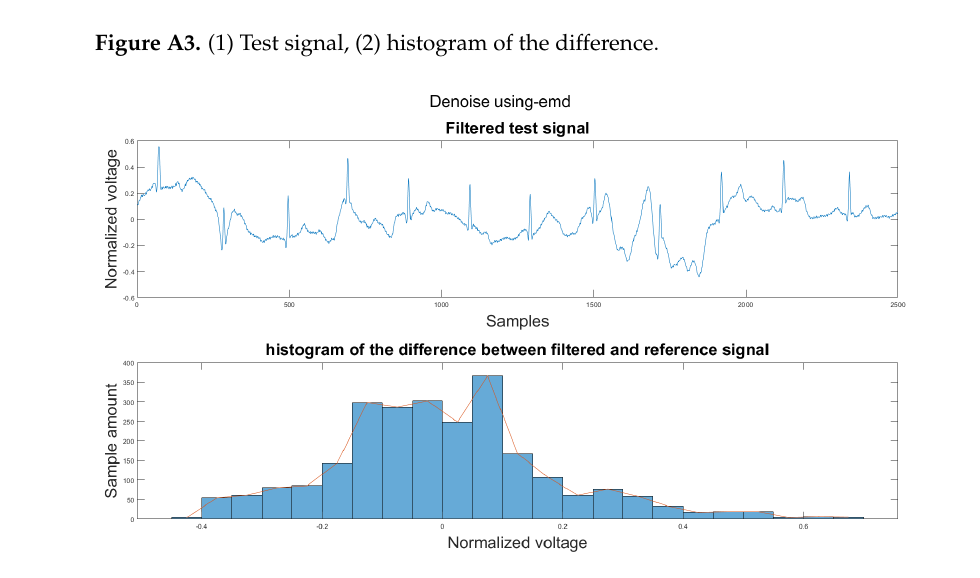
Figure A4. (1) Test signal, (2) histogram of the difference.